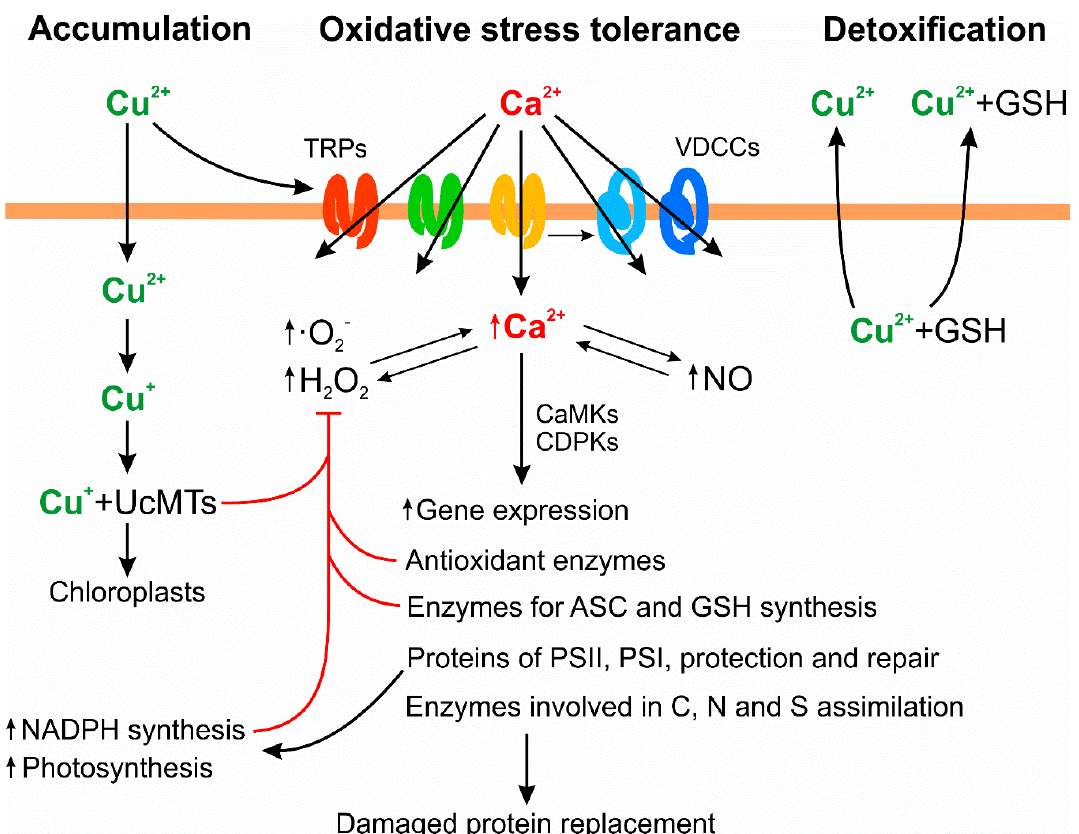
Figure 1. Scheme of copper-induced extracellular calcium entry through transient receptor potential (TRP) channels and voltage-dependent calcium channels (VDCCs) leading to the increases in intracellular calcium which crosstalk with increases in hydrogen peroxide and nitric oxide (NO). The increases in intracellular calcium activate CaMKs and CDPKs that, in turn, activate gene expression leading to enhance activities of antioxidant enzymes, ASC and GSH levels, proteins of photosystems (PSII and PSI) and proteins involved in protection and repair of PS, and enzymes involved in C, N, and S assimilation. The increase in photosynthesis enhances NADPH levels that coupled to the increase in ASC and GSH levels and in activities of antioxidant enzymes participate in the buffering of copper-induced oxidative stress. In addition, the binding of copper ions to UcMTs, the accumulation of copper-containing particles in chloroplasts, and the copper extrusion with GSH also participate in the buffering of oxidative stress. TRPs are indicated in red, green, and yellow; VDCCs are indicated in light and dark blue; red arrows indicate inhibitory processes; and black arrows indicate activation processes.